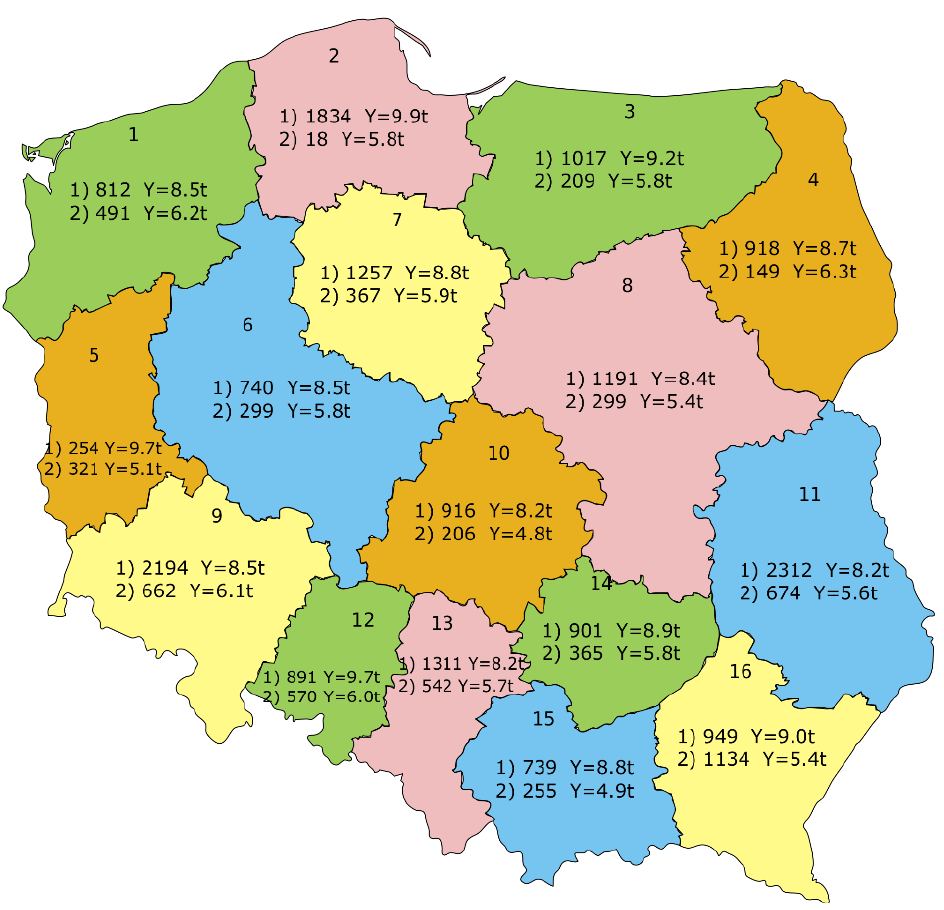
Figure 1. Number of entries from each field type (1)—PRVTS (the Polish Post-Registration Variety Testing System in multi-environmental trials, the experimental fields), (2)—IHAR (the Laboratory of Economics of Seed and Plant Breeding of Plant Breeding and Acclimatization Institute-National Research Institute, the farmers’ fields) in each of 16 voivodeships in Poland with the average yield obtained at each field type. Numbers indicate voivodeships in Poland: 1 zachodniopomorskie (West Pomeranian), 2 pomorskie (Pomeranian), 3 warmi´nsko-mazurskie (Warmian-Masurian), 4 podlaskie (Podlaskie), 5 lubuskie (Lubusz), 6 wielkopolskie (Greater Poland), 7 kujawsko-pomorskie (Kuyavian- Pomeranian), 8 mazowieckie (Masovian), 9 dolno´sl ˛askie (Lower Silesian), 10 ł ó dzkie (Ł ó d´z), 11 lubelskie (Lublin), 12 opolskie (Opole), 13 ´sl ˛askie (Silesian), 14 ´swi˛etokrzyskie (Holy Cross), 15 małopolskie (Lesser Poland), 16 podkarpackie